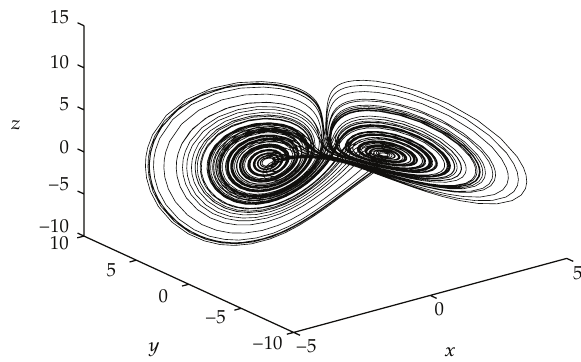
Figure 2: Chaos still exists for K (cid:7) − 1 , τ (cid:7) 0 . 2.